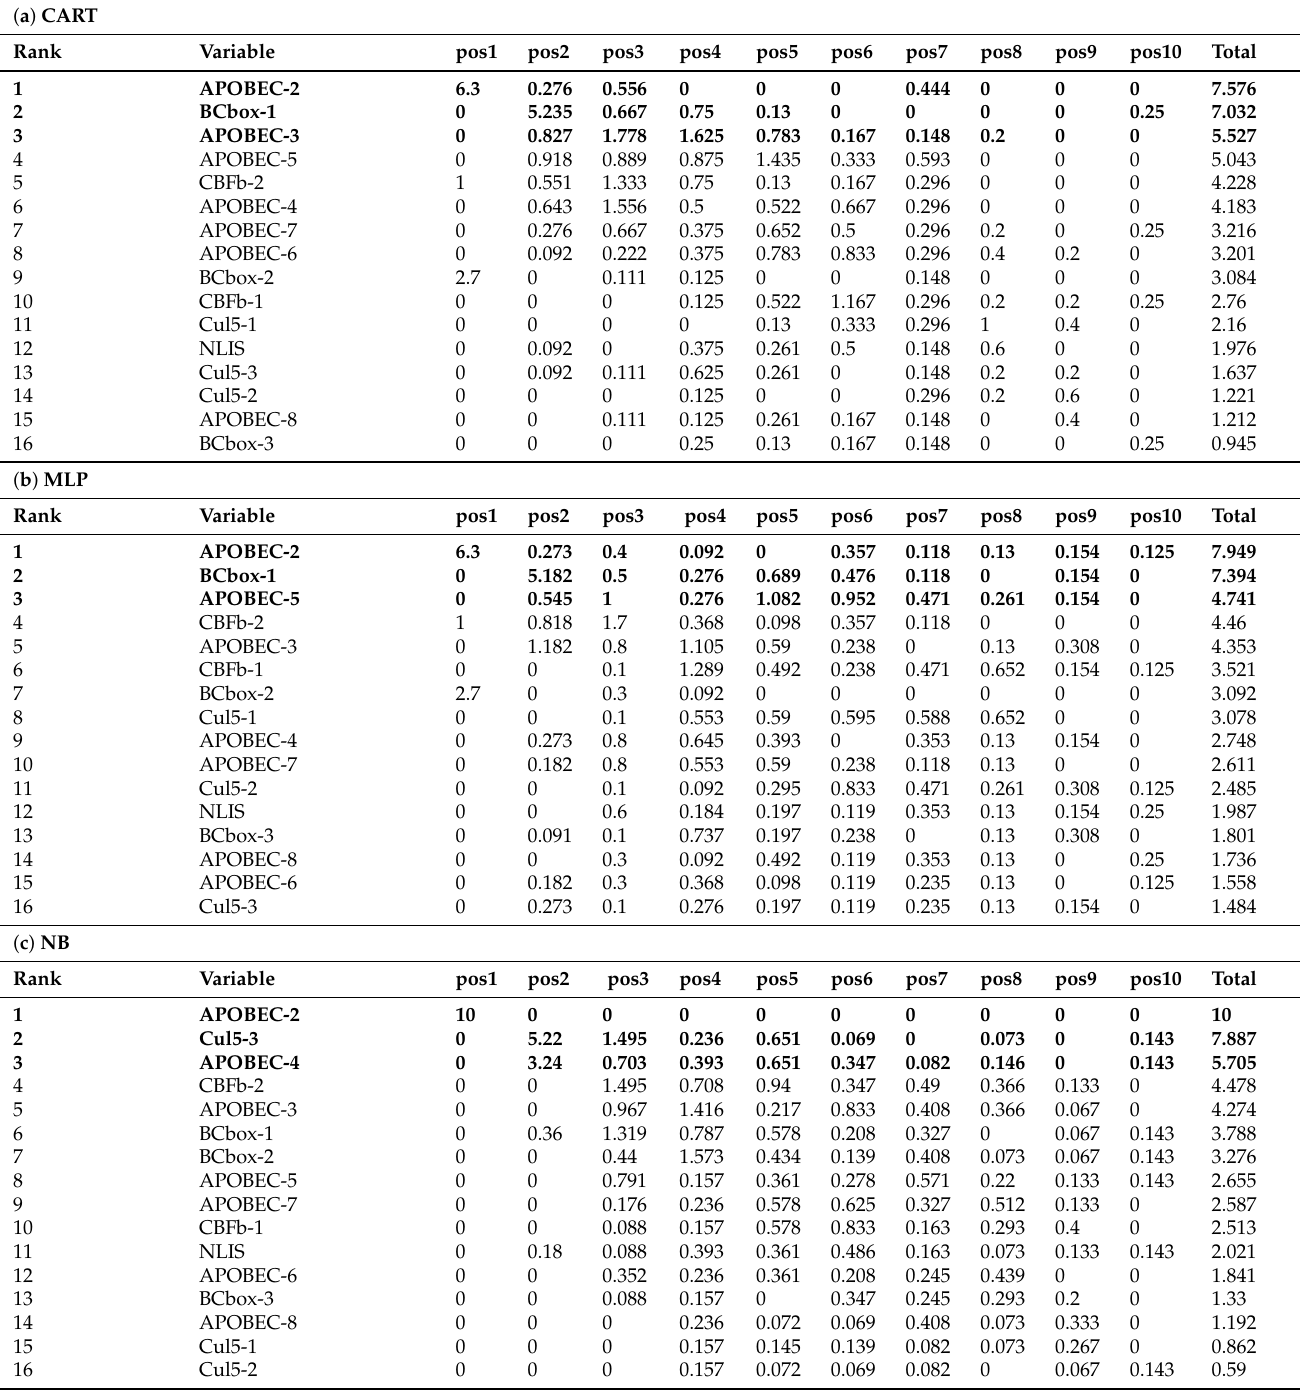
Table A3. Relevance scores ( r ) in descending order per algorithm and variable considering the clinical endpoint VLIni using the MAREV-1 approach. The three variables with higher values are highlighted in